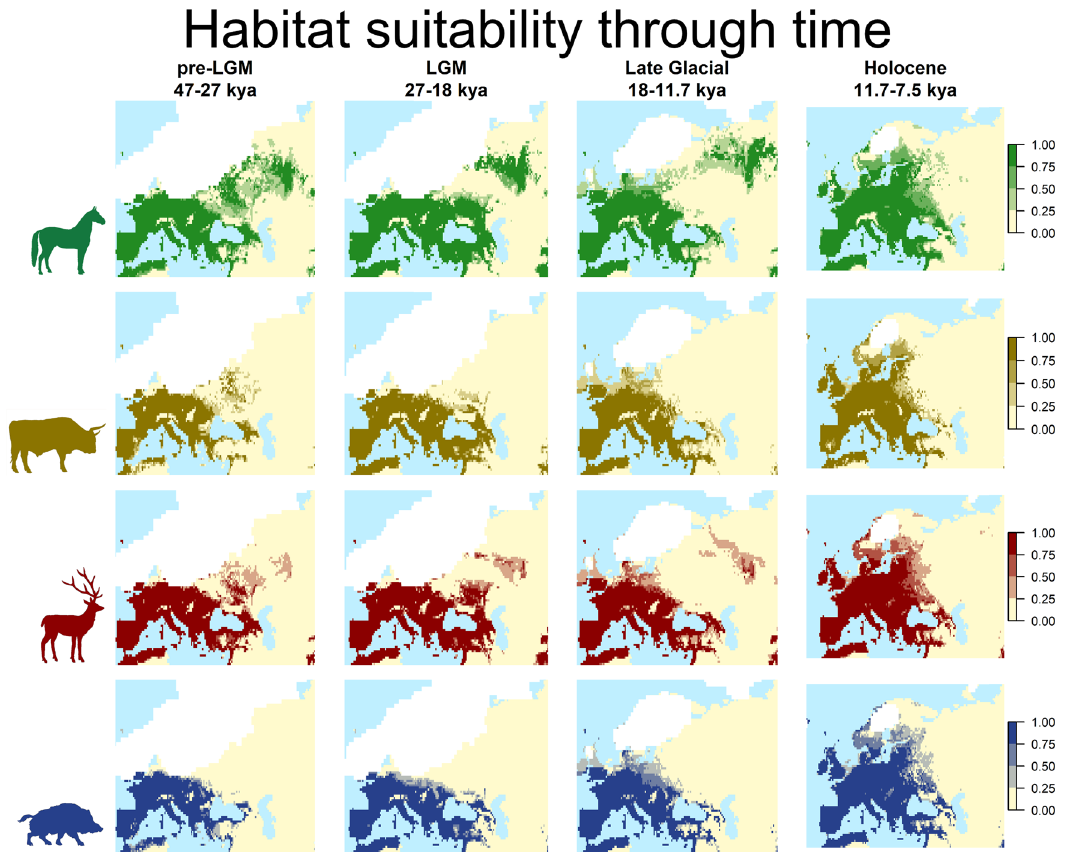
Fig. 4 Potential distribution of the species for each climatic period. Each map represents the mean distribution over time during each period, based on the best ensemble for each species. The maps show only cells de fi ned as land in the whole period considered and the largest ice cover observed during the same time frame.